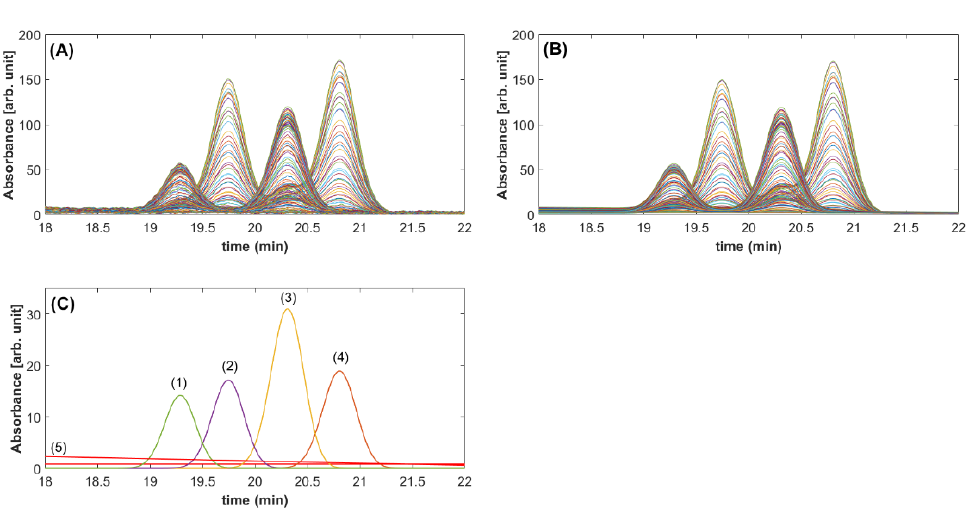
Table 1. Figures of merits (FOM) of the calibration curves using (A) itMPF with fminsearch used as optimization algorithms, (B) itMPF with fminnunc used as optimization algorithms, (C) classical ap- proach with detection at 290 ± 4 nm. Standards were made by mixing the four diterpenes at different concentrations.